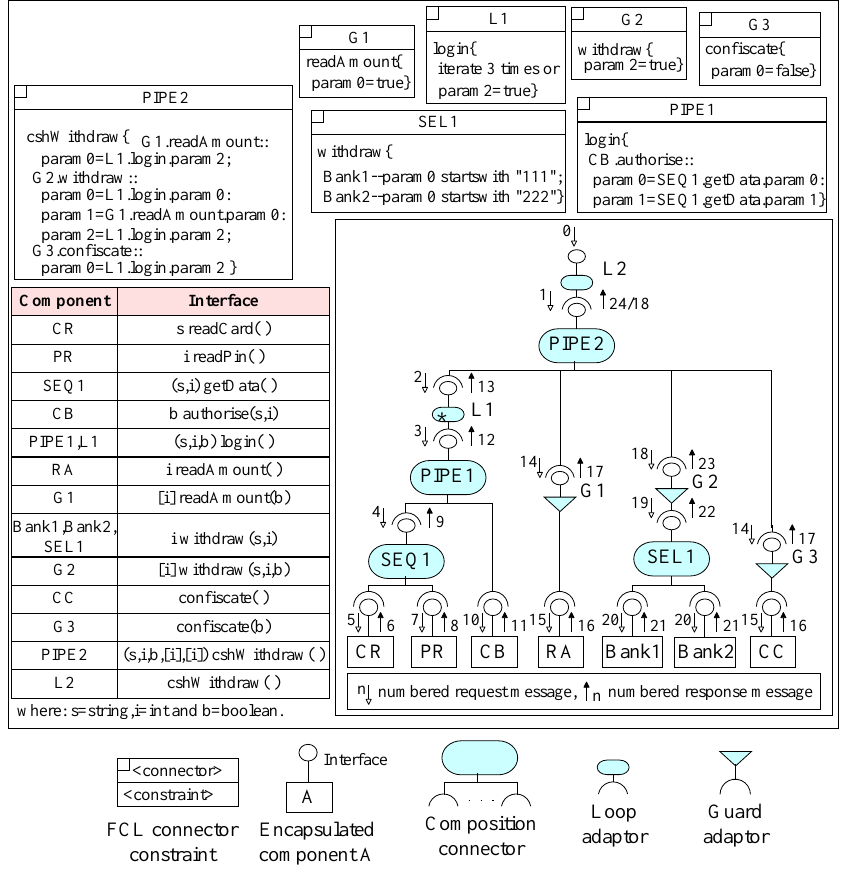
Figure 27. The ATM system detailed